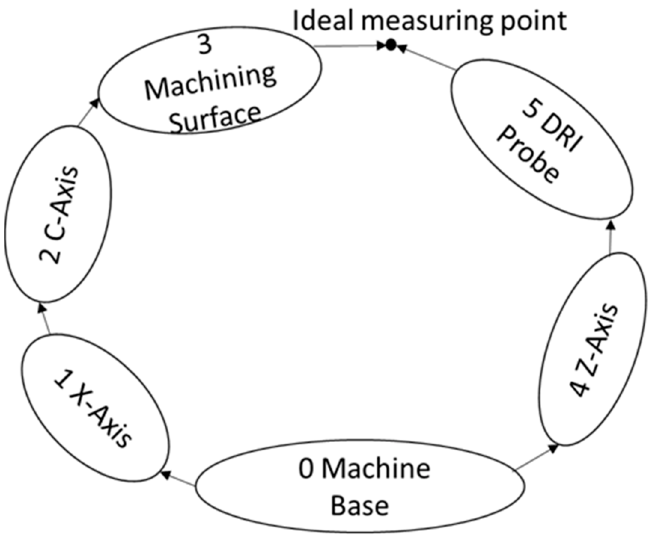
Figure 3. Kinematics error chain for an on-machine surface measurement system.